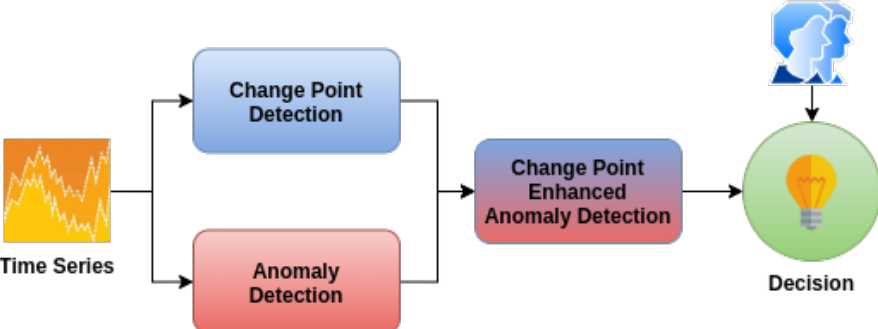
Figure 1. Proposed Solution